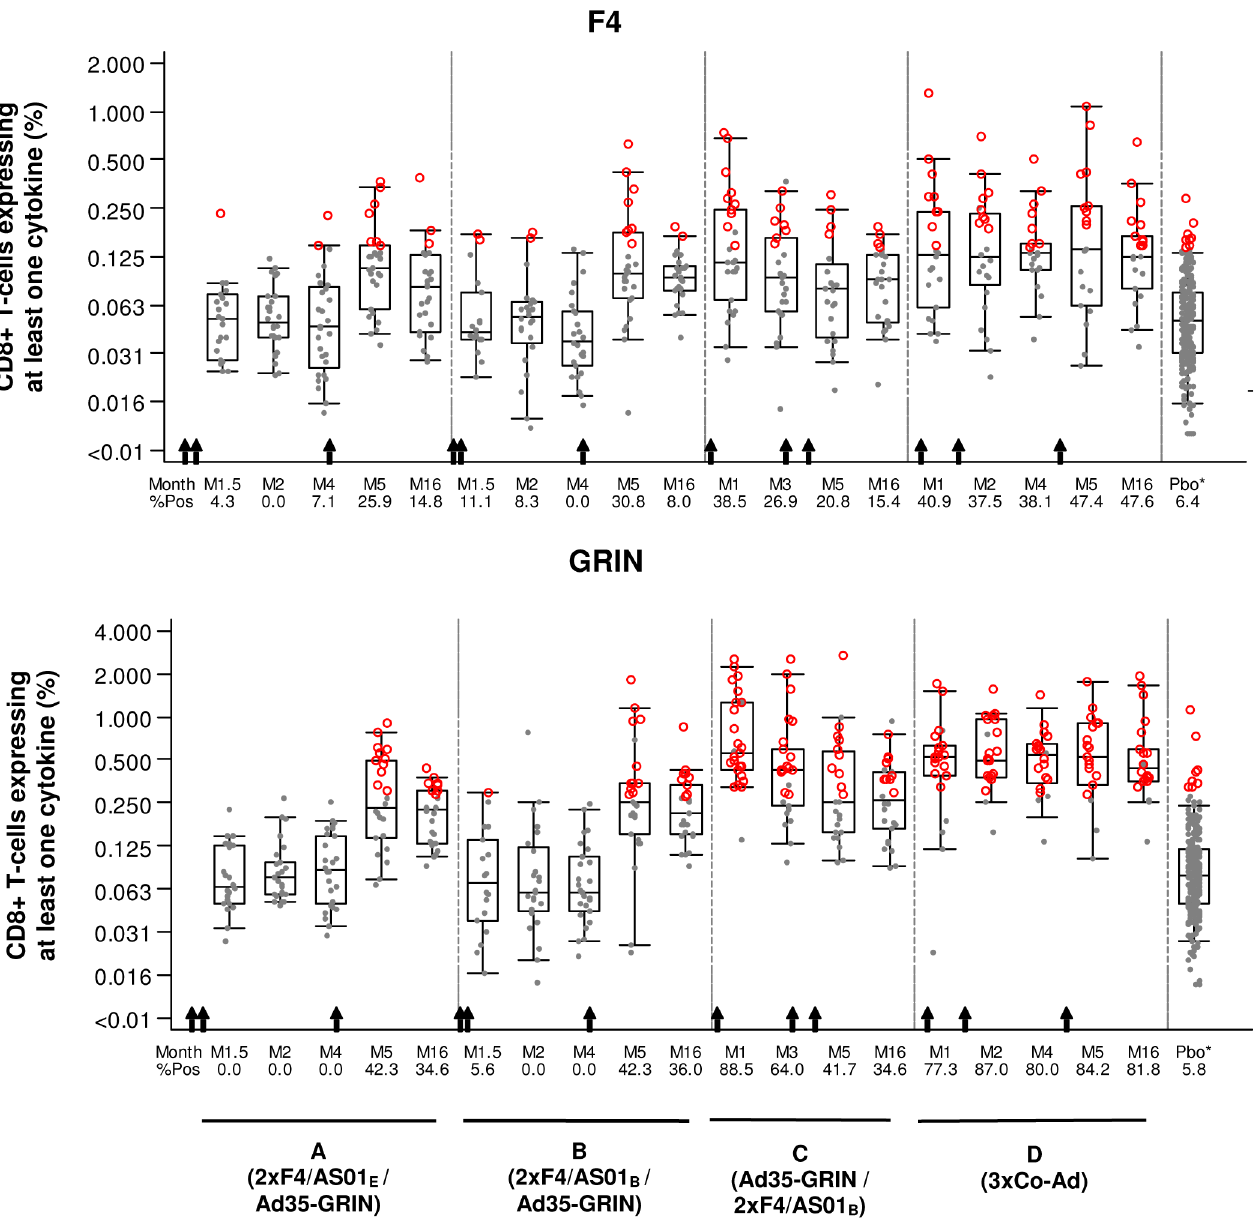
Fig 6. Kinetics of CD8+ T cell responses. The magnitude of the CD8+ T cells expressing at least one cytokine among IL-2, TNF- α and IFN- γ is shown for A. F4 (any of p24+RT+Nef+p17 peptide pools) and B. GRIN (any of Gag+RT+Int+Nef peptides pools). M: Months. Gray dots: response below the cut-off to any of the 8 peptide pools; red circles: response above the cut-off to any of the 8 peptide pools. All baseline and placebo (Pbo * ) groups are combined in the far right box plot. The arrows indicate when the vaccines were given for each group (lower